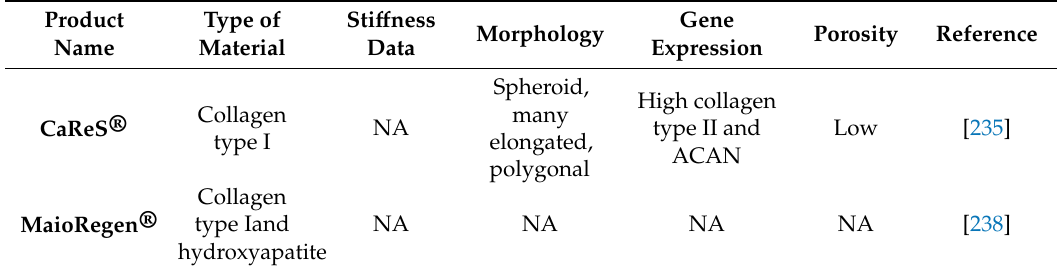
Table 2. Cell-free biomaterials used for clinical articular cartilage